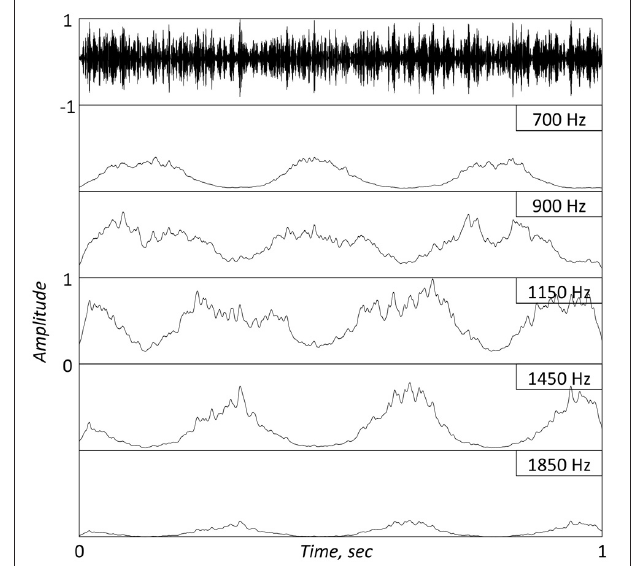
FIGURE 2 | Top panel. A 1s long FM stimulus with a complex carrier centered at 1KHz, modulated by a 3Hz sinusoid. [Provided by Obleser; see description at Obleser et al. (2012)]. Bottom Panels : Same as in bottom panels of Figure 1 . Note the re-generation of the modulating signal at the cochlear output. The jitters in the IHC response are a reflection of the non-flat temporal envelope of the full-band